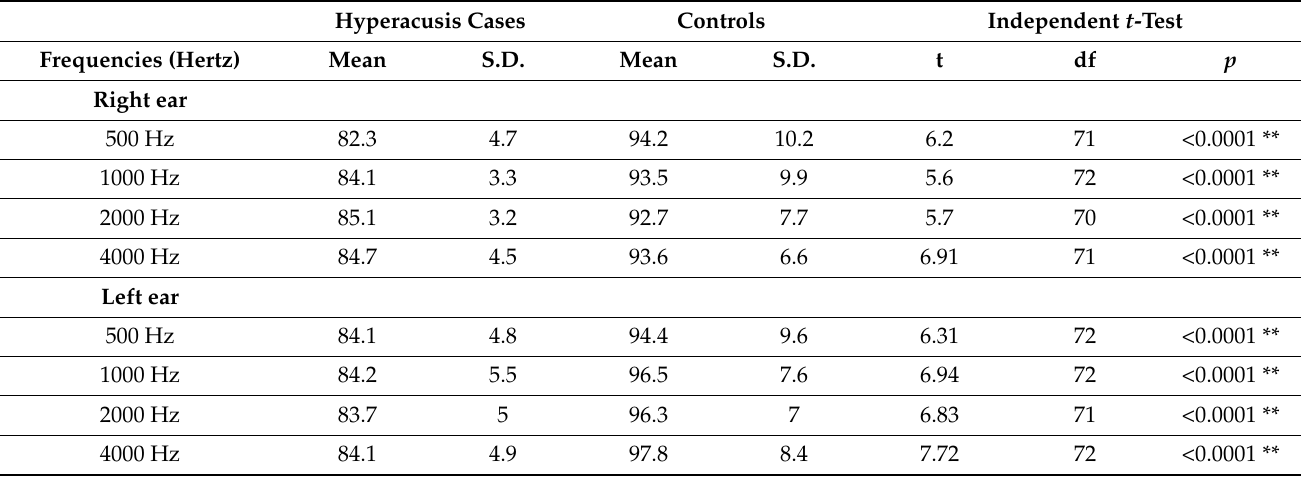
Table 2. Mean scores and standard deviation of LDLs (loudness discomfort levels) expressed in decibel are displayed for both ears. The significance level is reached for p values < 0.05 and <0.005 (**).